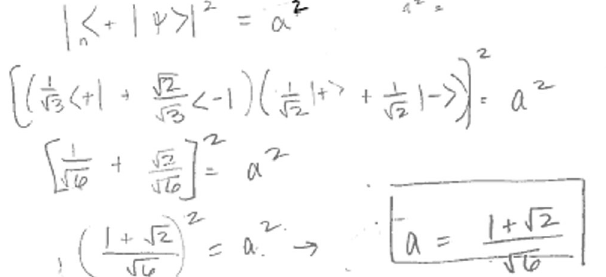
FIG. 9. Portion of a student ’ s solution where they used probability calculations to find the expansion coefficients in a new basis representation. They started a probability calculation, j hþj ψ ij 2 , but rather than complete the complex square, they just x took the result of the inner product from inside the complex square.